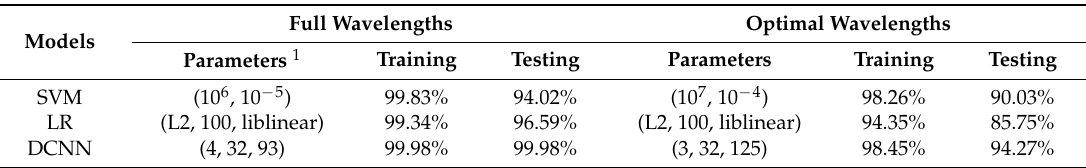
Table 1. Discrimination results of Chrysanthemum varieties by different models using full wavelengths and optimal